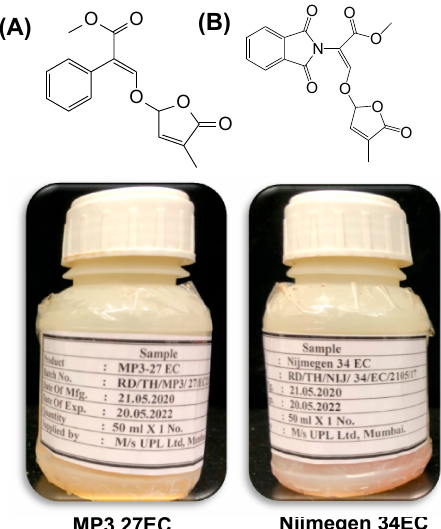
Figure 1. Structure of selected SL analogs and packaging of Emulsifiable Concentrate (EC) formu- lation of strigolactone analogs, developed by UPL, India ( A ) MP3 27EC and ( B ) Nijmegen 34EC, prepared by UPL, India.